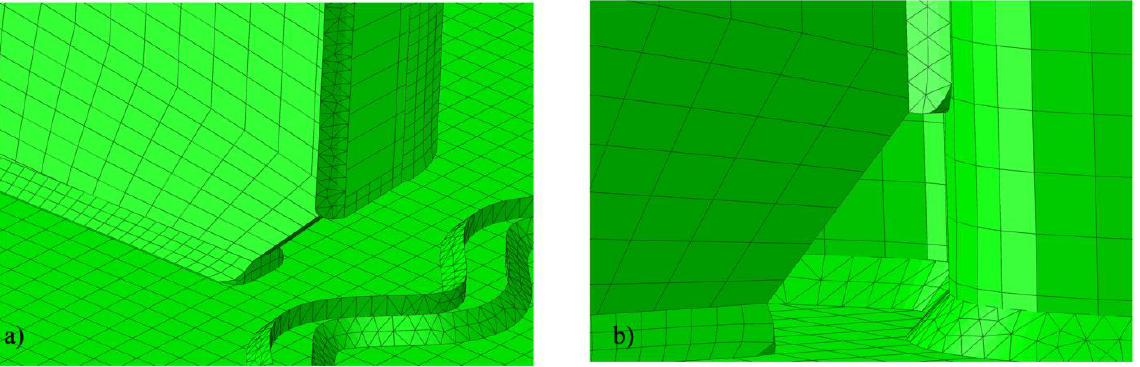
Figure 7. Additional views on the discretization for a volumetric model of the girder (model 1). ( a ) the details of the weld discretization; ( b ) welded connection of the ribs with the sinusoidal web.